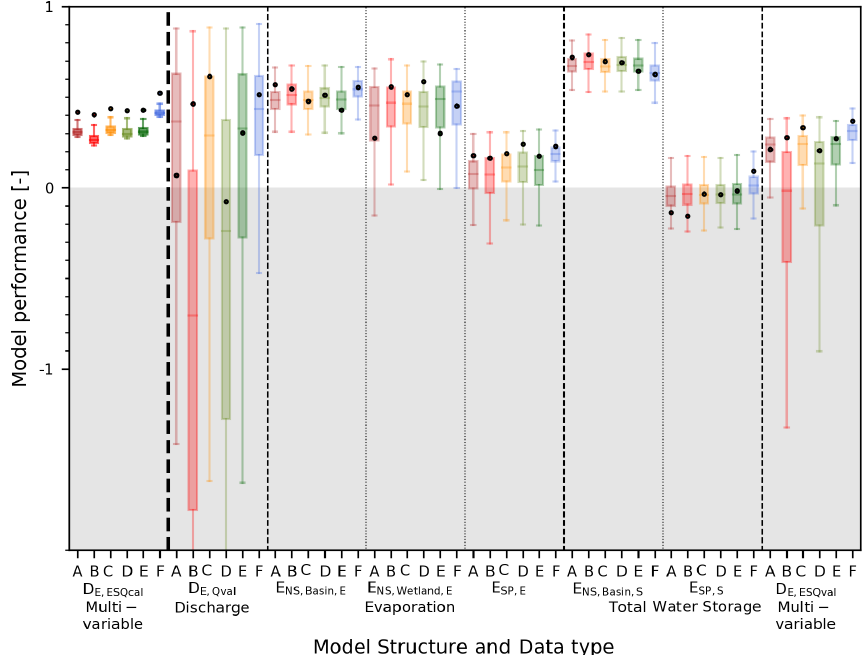
Figure 8. Model performance with respect to discharge, evaporation and storage for all models. The model is calibrated to multiple variables simultaneously ( D E , ES Q cal , darker boxplots in the first column) and evaluated with respect to each flux individually (lighter boxplots). The dots represent the model performance using the “optimal” parameter set and the boxplot the range of the best 5% solutions, both according to D E , ES Q cal . The following performance metrics were used: (1) discharge using the overall model performance metric ( D E ,Q val ), (2) tempo- ral evaporation basin-average ( E NS , Basin , E ), (3) temporal evaporation, wetland areas only ( E NS , Wetland , E ), (4) spatial evaporation ( E SP , E ), (5) temporal storage basin-average ( E NS , Basin , S ), (6) spatial storage ( E SP , S ) and (7) the combination of evaporation, storage and discharge (combined metric D E , ES Q val